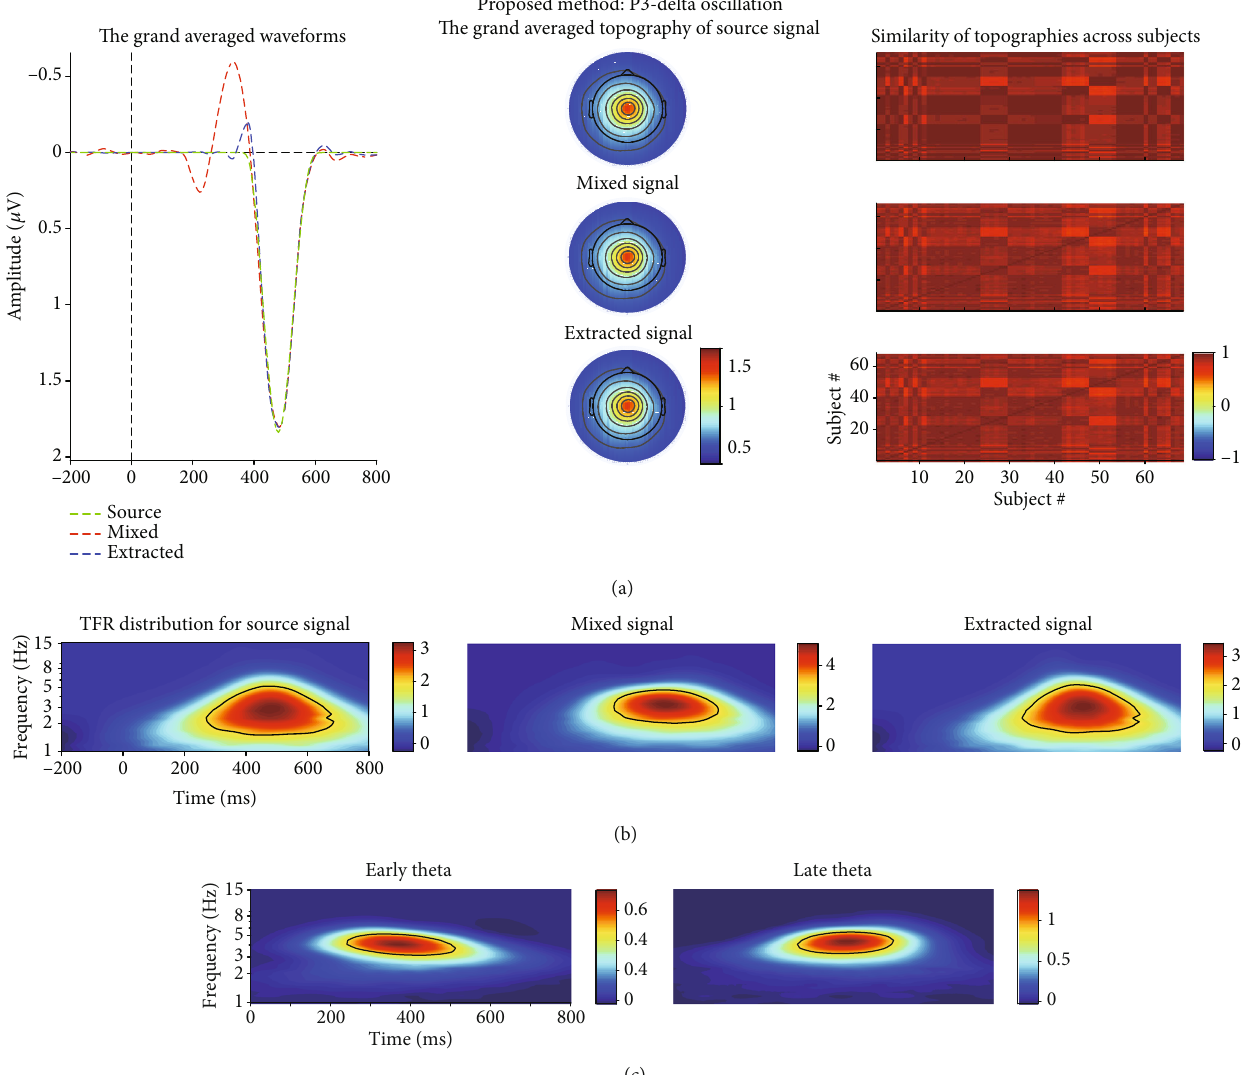
Figure 4: (a) The grand averaged waveform at Cz electrode, topography (the time window was from 400 to 550ms), and similarity of topographies among subjects of the source/mixed/extracted P3 for the synthetic dataset when SNR is equal to 10dB. (b) The associated grand averaged time-frequency representations (TFRs) at Cz of the source, mixed, and extracted (by the proposed approach) signals for P3-delta oscillation separately. The mixed signal plays the role of the preprocessed ERPs with the consideration of a real ERP dataset. (c) Weighted TFRs of early and late theta using TFA-PCA.